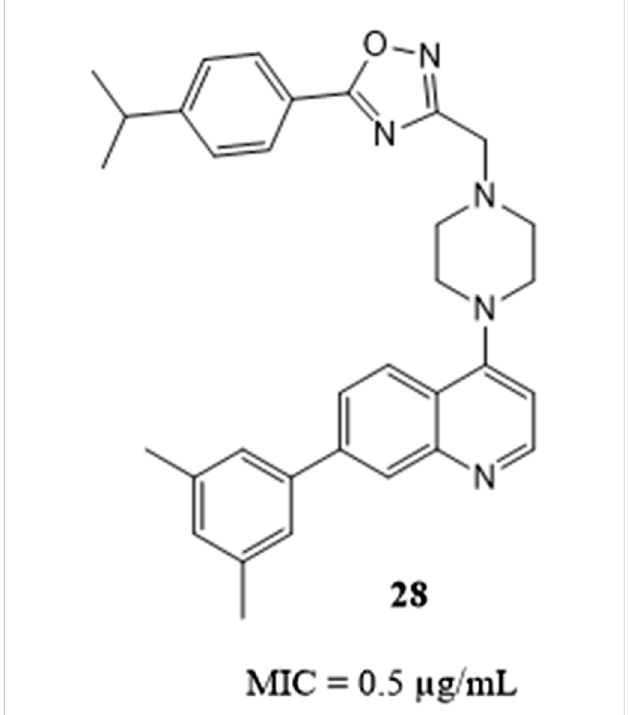
FIGURE 6 Quinoline-oxadiazole hybrid with antitubercular